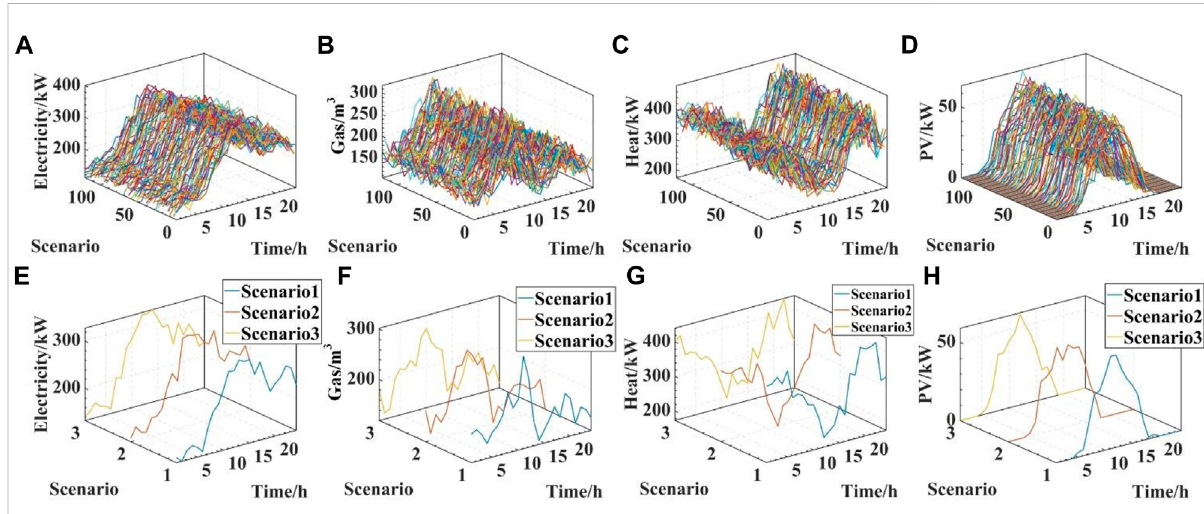
FIGURE 4 GAN-generatedscenariosfor: (A) electricity loads; (B) gasloads; (C) heatloads; (D) PV outputs; reducedscenariosbyK-meansclustering inthe corresponding GAN-generated scenarios for: (E) electricity loads; (F) gas loads; (G) heat loads; (H) PV outputs.